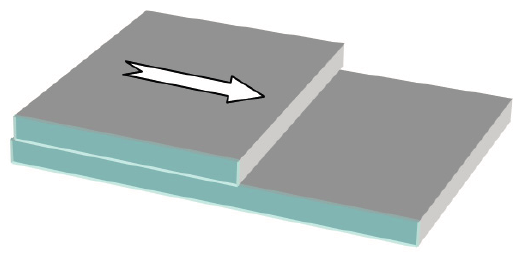
Figure 1. Application of stylus profiler to thin film thickness